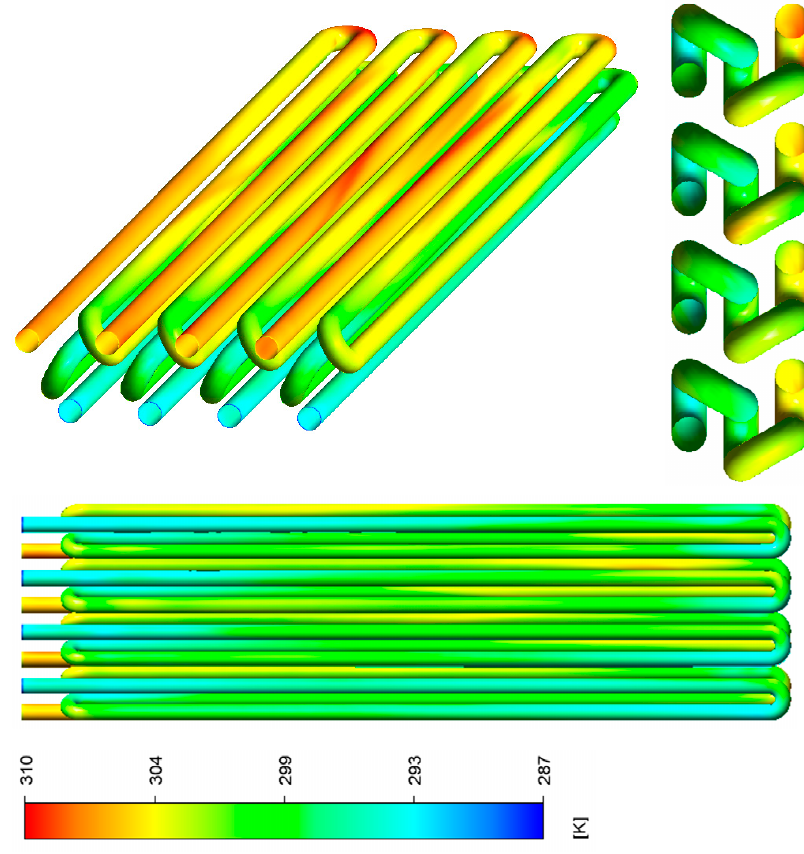
Figure 10. The distribution of temperature across the coil wall from various perspectives.